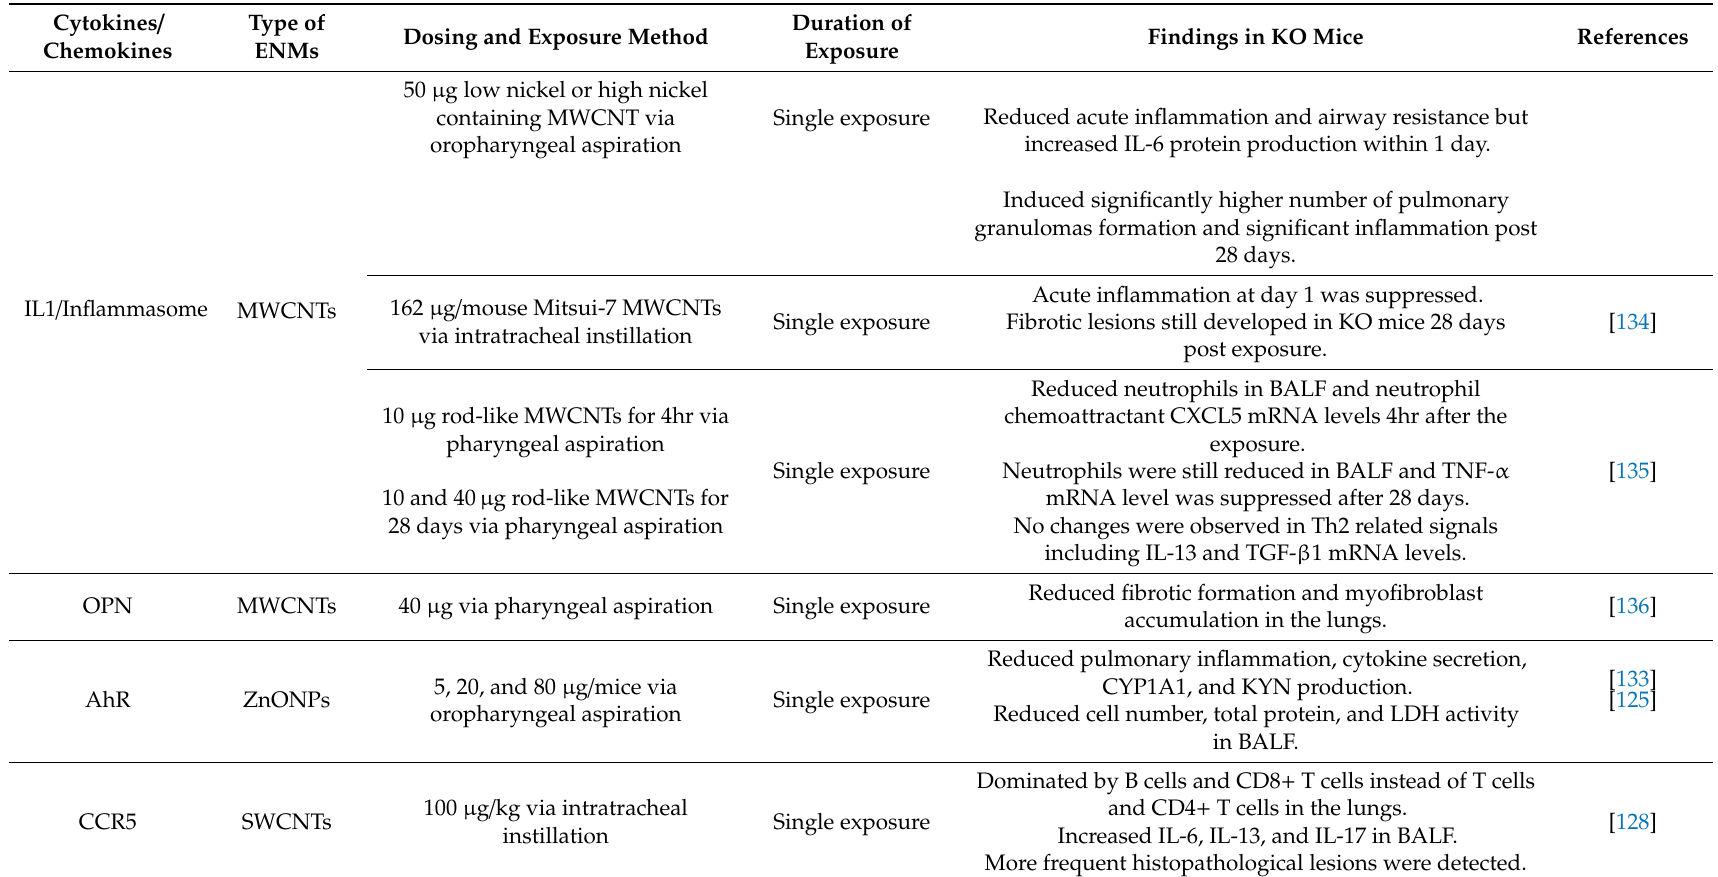
Table 3. Summarized list of receptors and cytokines / chemokines that may be involved in the susceptibility to ENM-induced chronic lung